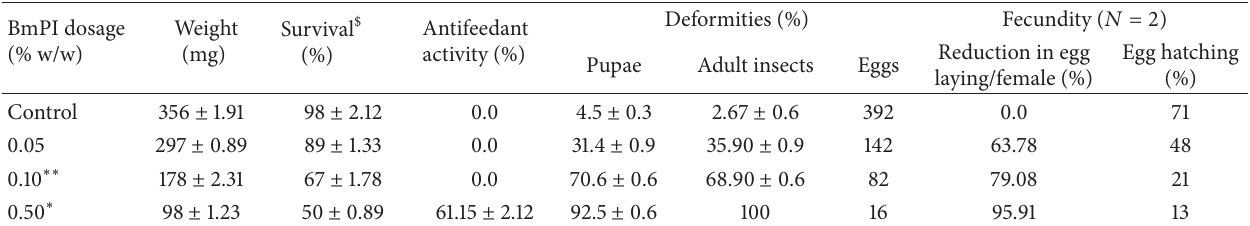
∗ Indicates LD ∗∗ indicates ED 50 and 50 ; N : two pairs of moths (two males and two females). $ Survival of larvae (%) = (number of insects alive in test/number of insects alive in control) × 100. ED